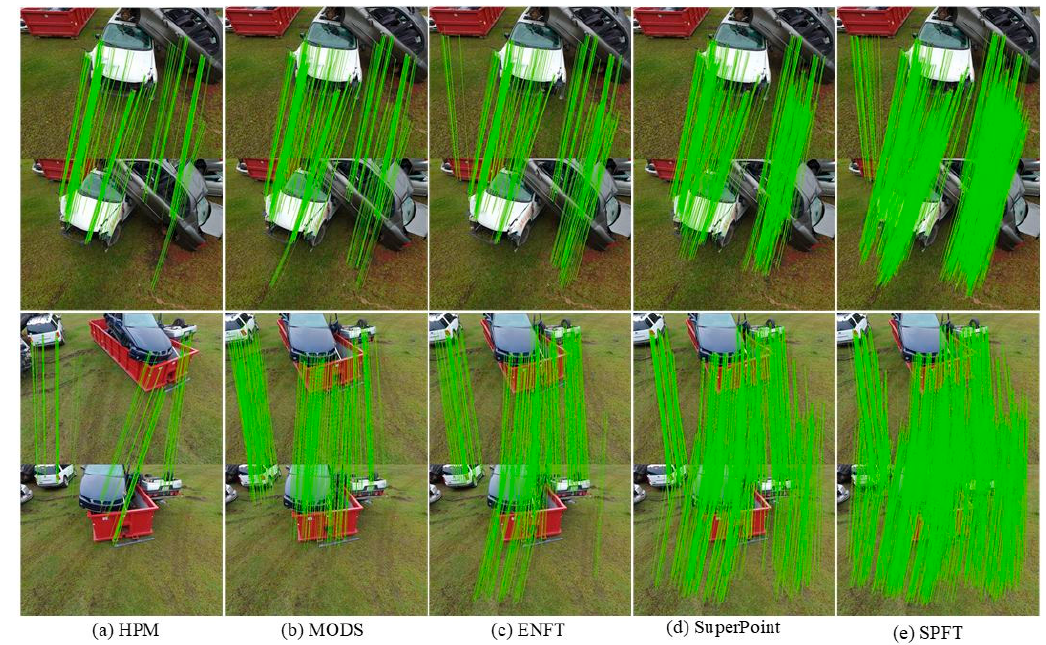
Figure 13. Visual correspondences for each method on Forensic dataset.